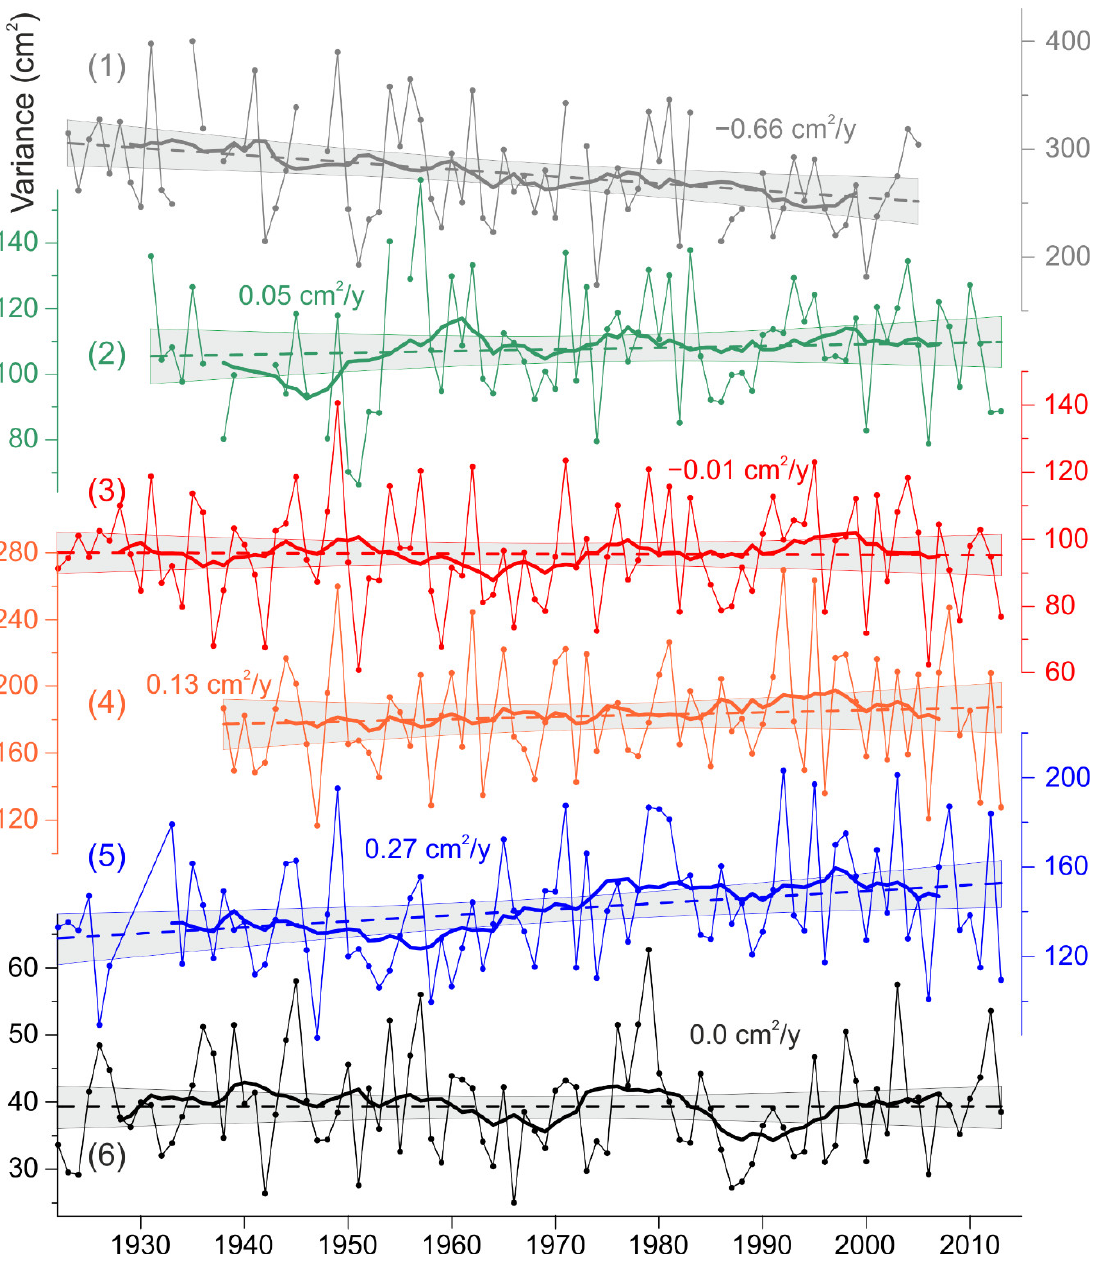
Figure 7. Interannual changes of the synoptic Baltic Sea level oscillation variance at stations (1) Gedser, (2) Klagshamn, (3) Kungsholmsfort, (4) Furuogrund, (5) Ratan, and (6) Stockholm. The dashed line shows the long-term linear trends with 95% confidence intervals (the lighter shaded area); the bold solid line shows the 13-year moving average for the corresponding stations.